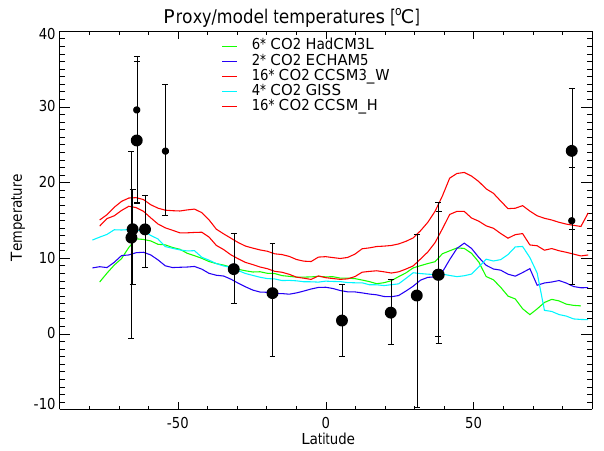
Figure 1. Zonal mean Eocene sea-surface temperature warming, presented as an anomaly relative to present or pre-industrial values. Warming from the five models in “Eomip” (Lunt et al., 2012) are shown as coloured lines; for each model only the CO 2 concentration that best fits the temperature proxy observations is shown. Warm- ing derived from the proxies are shown as filled circles, with error bars representing the range of uncertainty associated with proxy cal- ibration and temporal variability. Larger symbols represent “back- ground” early Eocene state, smaller symbols represent the EECO. Adapted from Fig. 8a in Lunt et al.